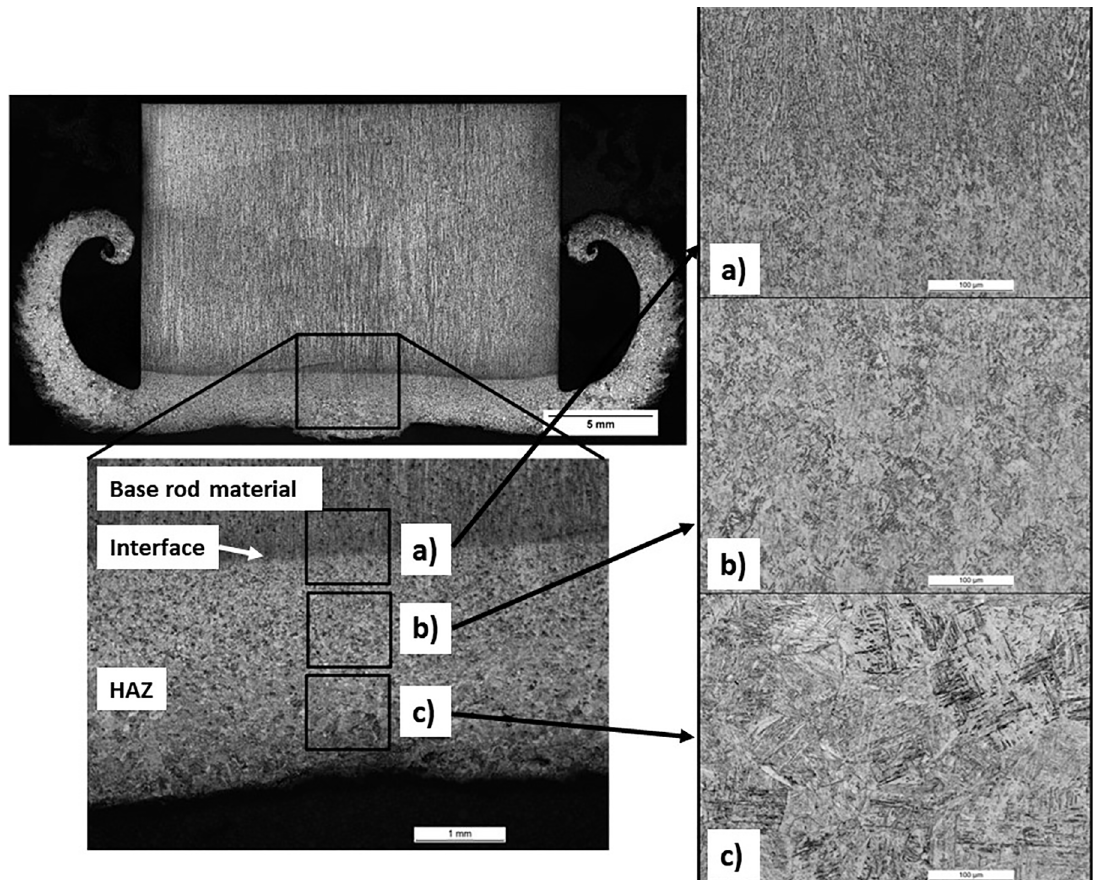
Figure 5. Microstructural evolution of the consumable rod: (a) transition zone between the base material of the rod and the HAZ of the rod; (b) acicular alpha grains after cooling and (c) prior beta grains until the rod